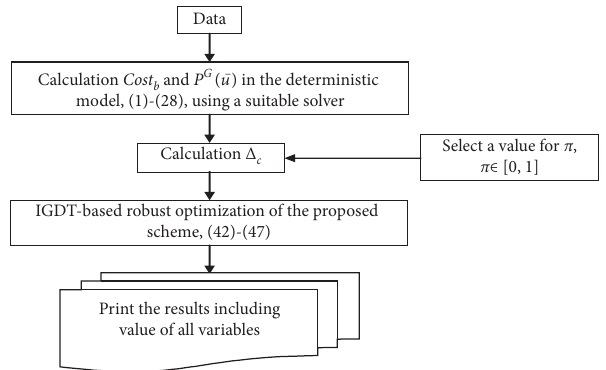
Figure 2: Flowchart of the problem